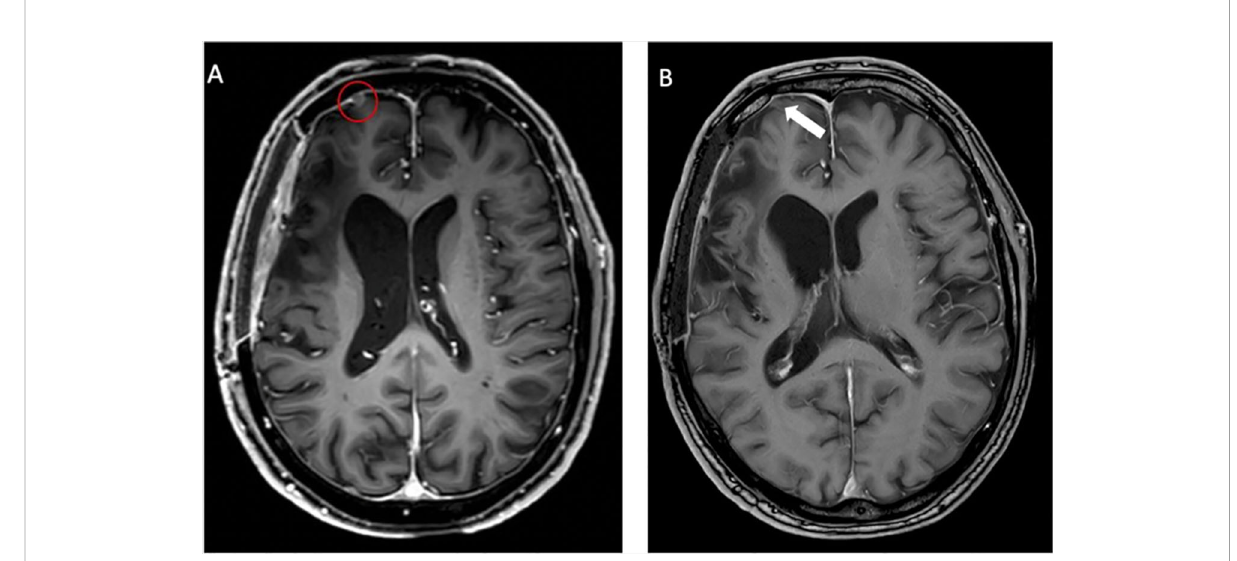
FIGURE 3 Follow-up MRI after 10 weeks (A) showing a progressive lesion (red circle) compared to the baseline MRI (B) . At initial evaluation, only a small dural alteration was observed (white arrow). In contrast, PET imaging detected considerably increased somatostatin receptor (SSTR) expression as assessed by 68 Ga-DOTATATE